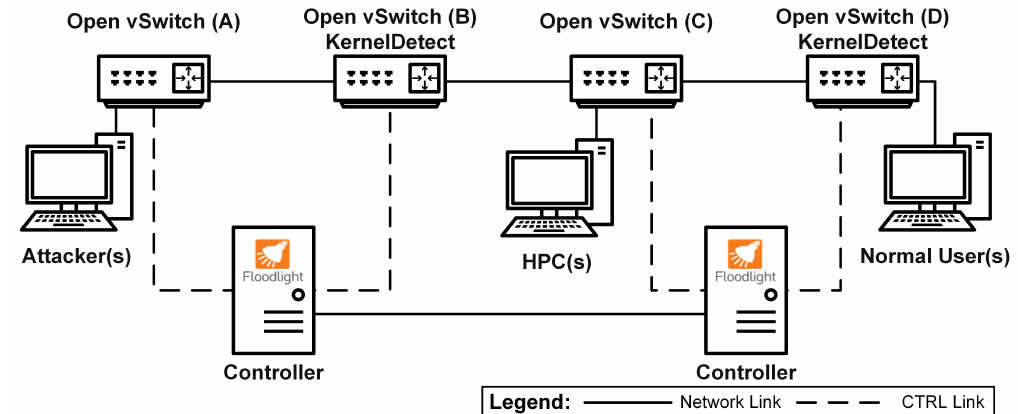
Figure 3. GENI experimental topology for evaluation where KernelDetect is only implemented in switches B and D as depicted in the diagram. Moreover, CTRL links are the communication medium between each SDN switch and their respective controller. Lastly, our experimental evaluation interchanges KernelDetect-enabled switches with SNORT and BRO for our comprehensive